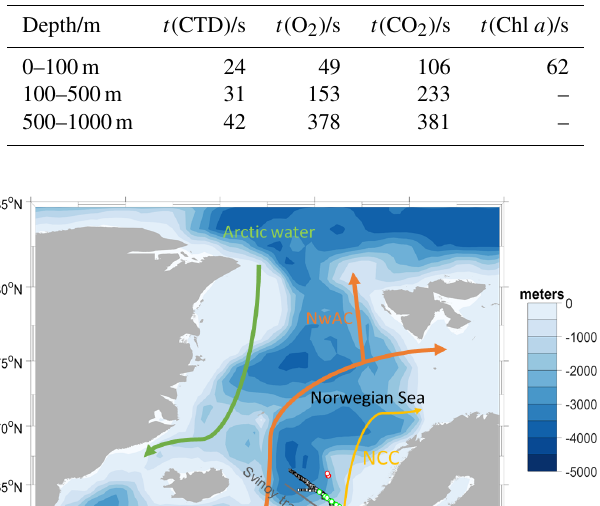
Table 1. Average sampling interval of Sea-Bird CTD, Aanderaa 4330F oxygen optode, Aanderaa 4797 CO 2 optode and a combined backscatter/chlorophyll a fluorescence sensor (Wetlabs Eco Puck BB2FLVMT) in the top 100, from 100 to 500 and from 500 to 1000m.